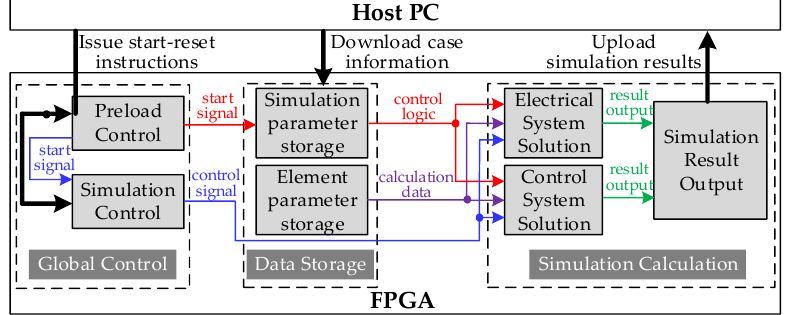
Figure 1. Structure of the field programmable gate array (FPGA)-based real-time simulator.